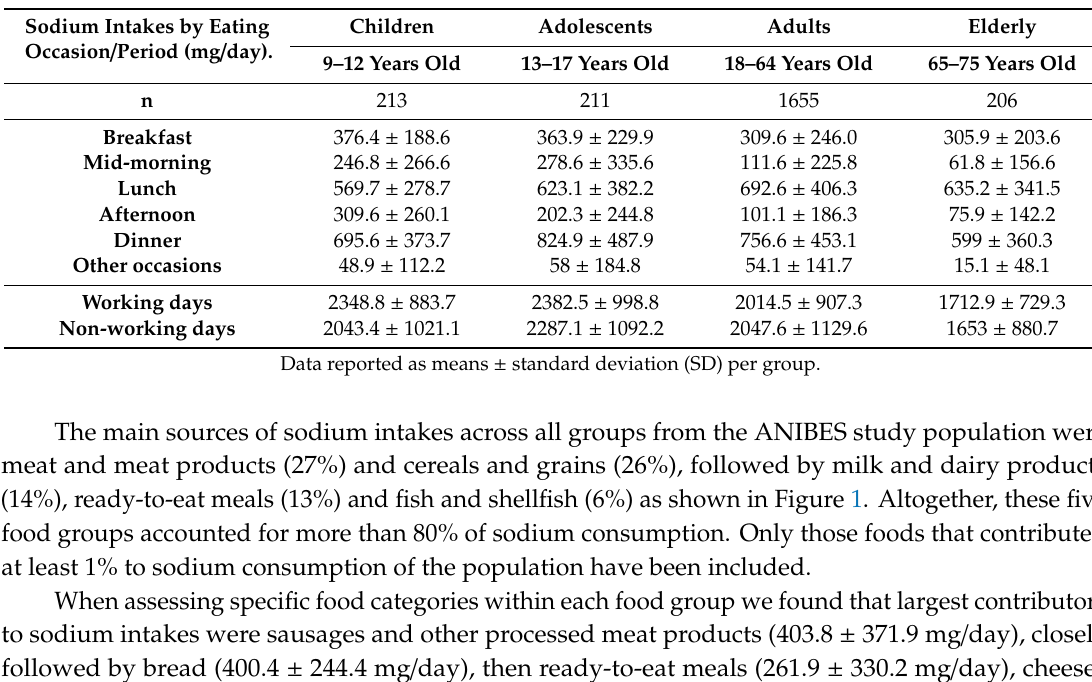
Table 3. Sodium intakes from foods consumed at di ff erent eating occasions by age groups from the ANIBES study population (excluding added table and cooking salt).